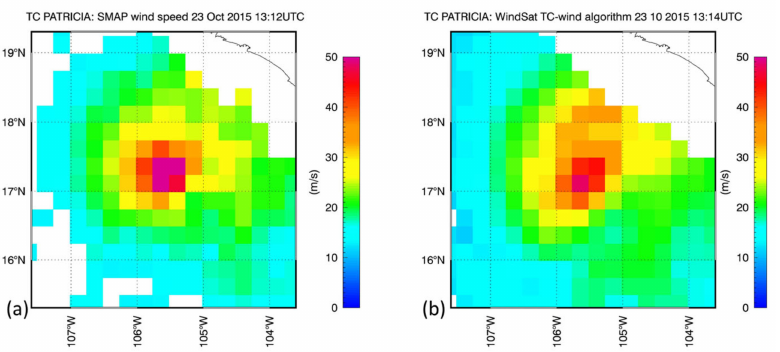
Figure 2. Passes of AMSR2 and WindSat over Hurricane Patricia on 23 October 2015. ( a ) SMAP wind speed. The SMAP pass occurred at around 13:12 UTC. ( b ) WindSat TC-wind speed. The WindSat pass occurred a couple minutes later.